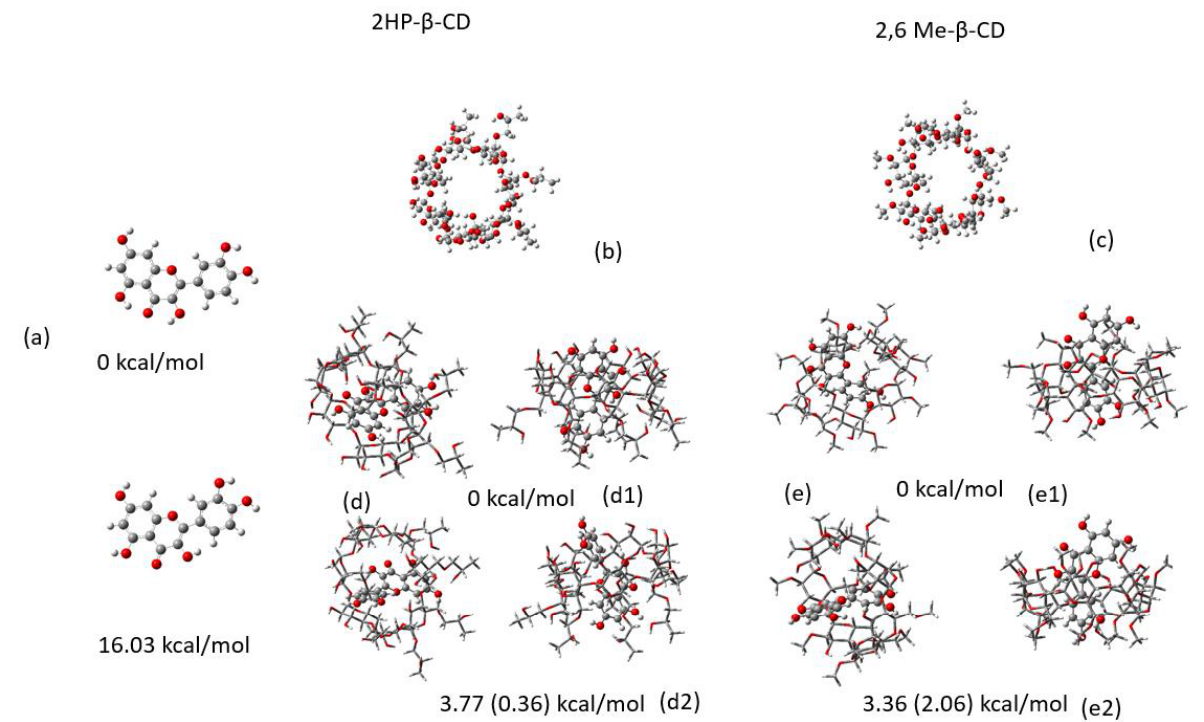
Figure 6. Calculated minimum energy structures: ( a ) QUE (above) and a local minimum of QUE (bottom), ( b ) 2HP- β -CD, ( c ) 2,6Me- β -CD, ( d ) complex of QUE with 2HP- β -CD ( d1 ) and complex of reversed QUE with 2HP- β -CD ( d2 ) from two different points of view, and ( e ) complex of QUE with 2,6Me- β -CD ( e1 ) and complex of reversed QUE with 2,6Me- β -CD ( e2 ) from two different points of view. All calculations were performed in water solvent using B3LYP/6-31G(d,p). The energy differences between the conformations in complexes are shown for the B3LYP level of theory; energy differences calculated using PM6 are shown in parentheses.